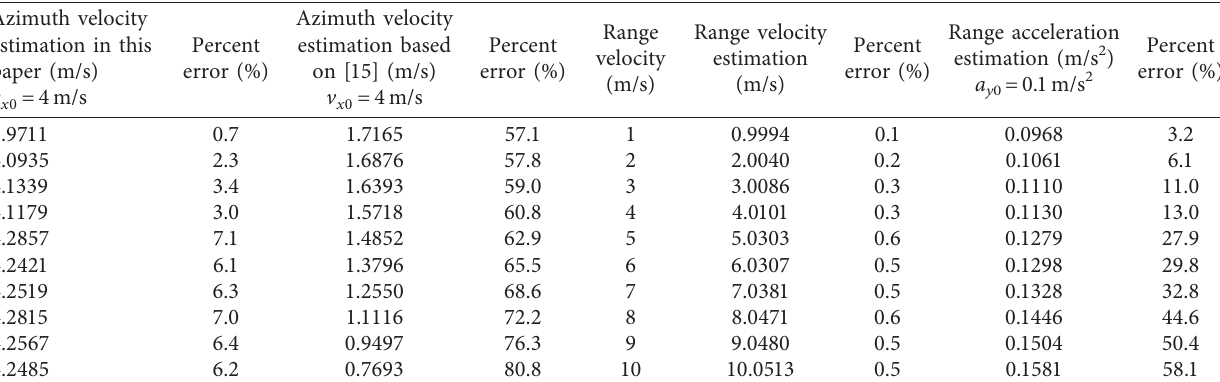
� 4 m/s and v � 4m/s. x 0 y 0